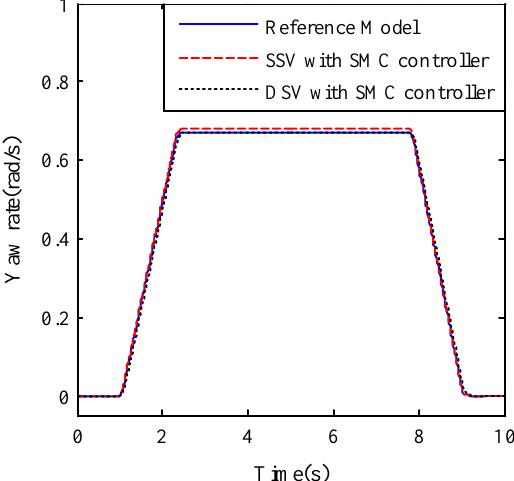
Figure 7. Yaw rate curves with k f 0 reduced by 5%.